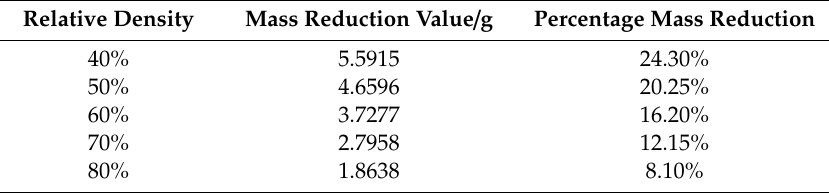
Table 3. Design mass reduction value and percentage mass reduction of the stressed segment of the porous test